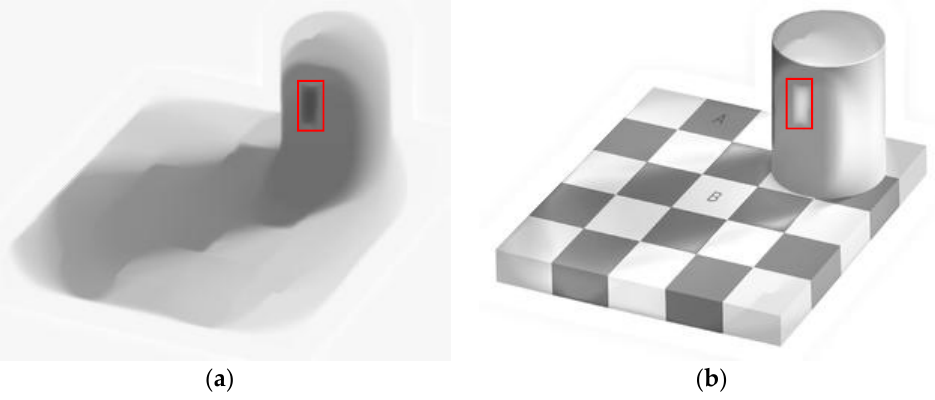
Figure 14. Reproduced illumination and reflectance (Figure 10a) ( a ) Illumination with fixed approximation; ( b ) Reflectance with fixed approximation. Note the circled part by the red square.